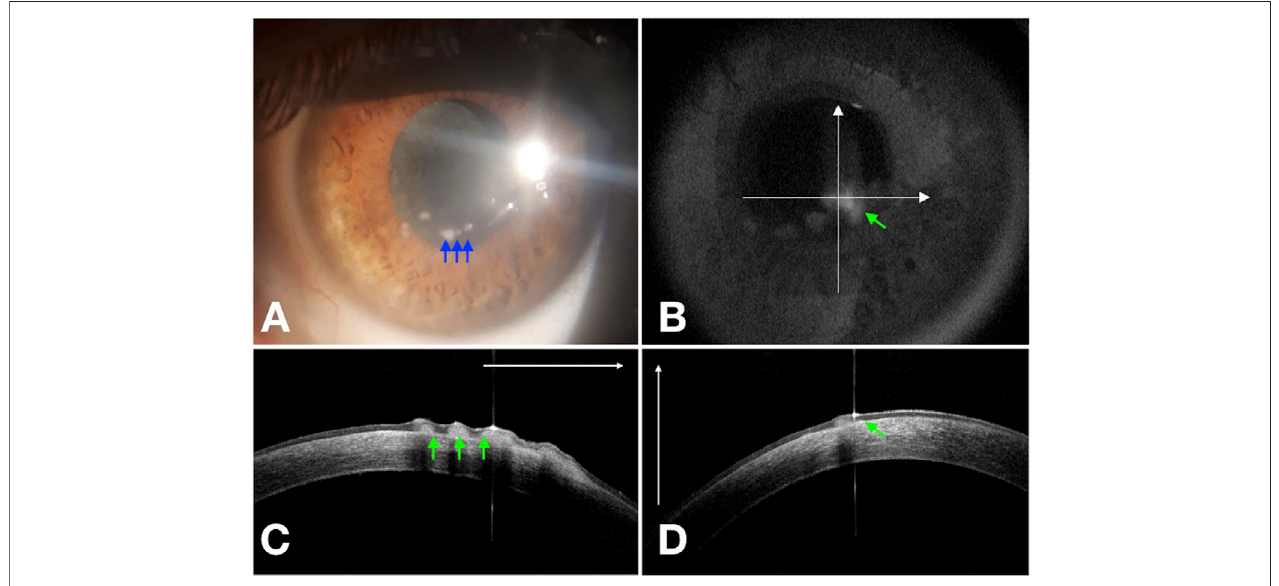
FIGURE2| Residualcornealepithelialhyperplasia(bluearrows)ofNK(rh-NGFCase4)atWeek8 (A) .Cross-lineOCT (B) con fi rmstheepithelialhyperplasia (green arrows) in the horizontal (C) and vertical (D) scans.